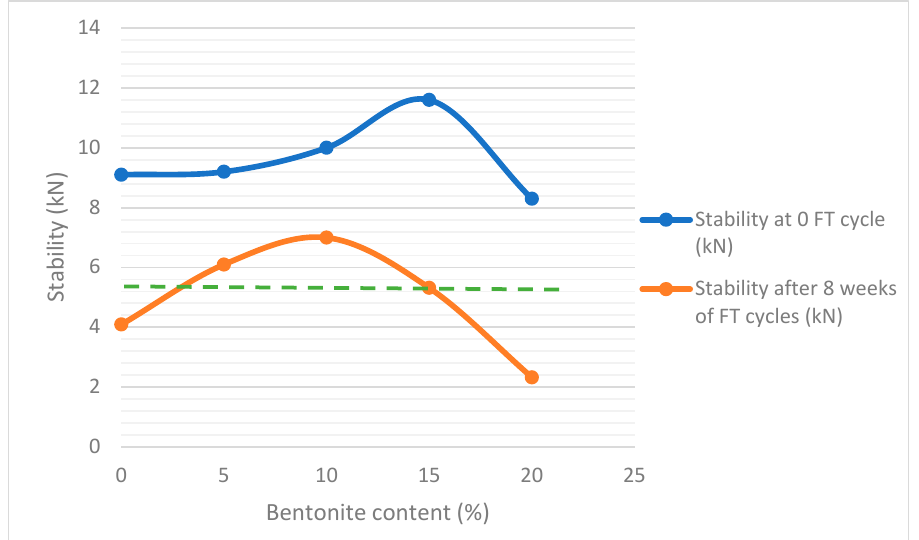
Figure 6. Average corrected stability (kN) vs bentonite content variation with FT cycles. The green dotted line represents the minimum requirement for stability.